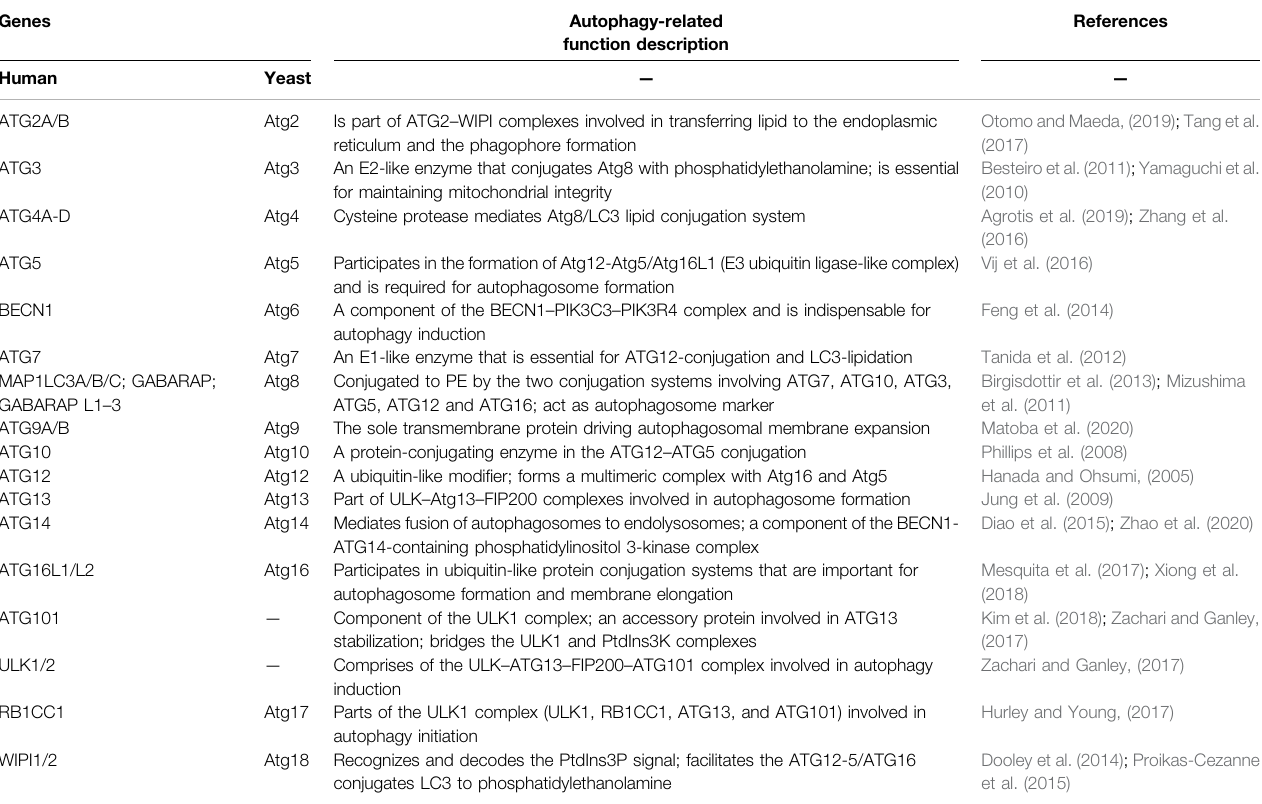
TABLE 1 | Autophagy-related genes and their function in